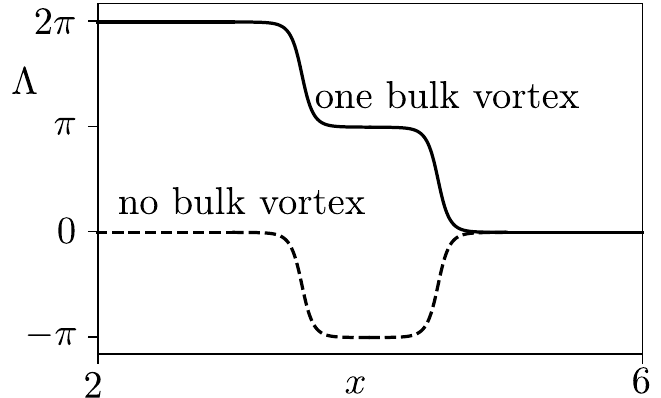
Figure 2: Phase field Λ ( x , t ) of the Majorana edge modes, calculated from Eq. (7) = 0 and x = 1 and plotted as a function of x for t = 4. for Josephson junctions at x 1 2 ( t ) = − φ ( t ) increases linearly from 0 at t = 0 to 2 π at t = 1. The phase φ ( t ) = φ 1 2 = 5. Solid and dashed curves The amplitude α ( t ) is calculated from Eq. (3) at W /ξ 0 are with and without a bulk vortex in between the Josephson junctions. The π -phase domain walls propagate in the + x direction with velocity v =